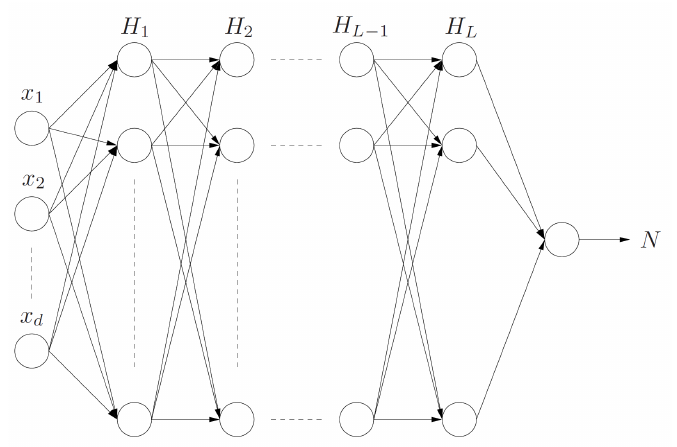
Figure 1. General structure of a multilayer perceptron with input x , L hidden layers and output N . Each neuron evaluates its inputs through predefined activation functions.